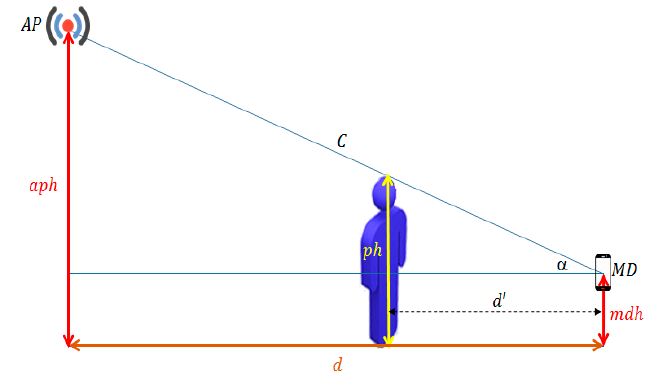
Figure 3. PPE influence distance ( d (cid:48) ) based on triangle geometry.